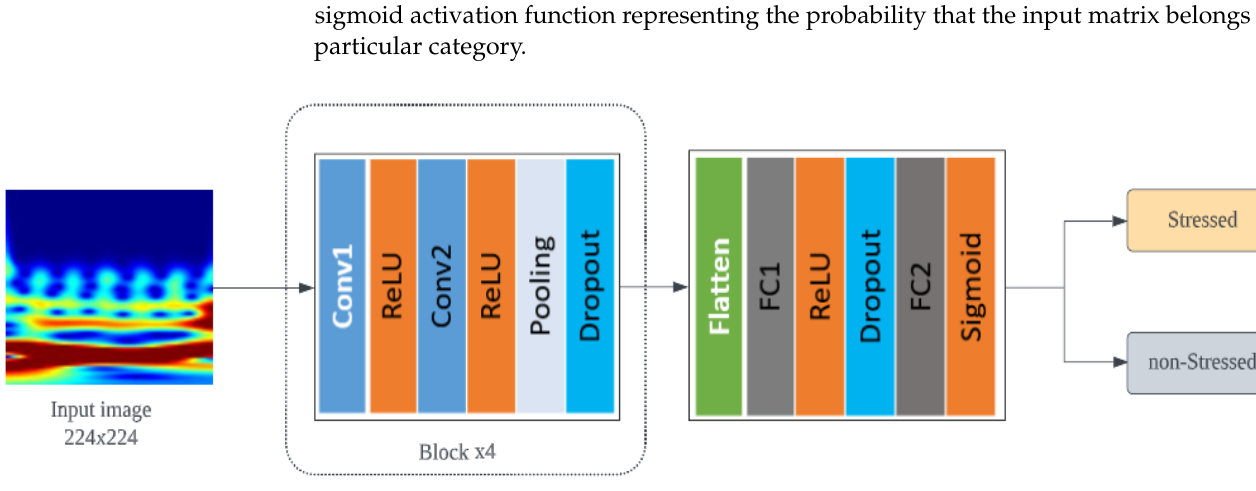
Figure 10. An overview of the proposed 2D-CNN method for mental stress detection. Table 4. Hyperparameters setting. Table 3. A summary of the setups of each layer of the network in the proposed CNN model.